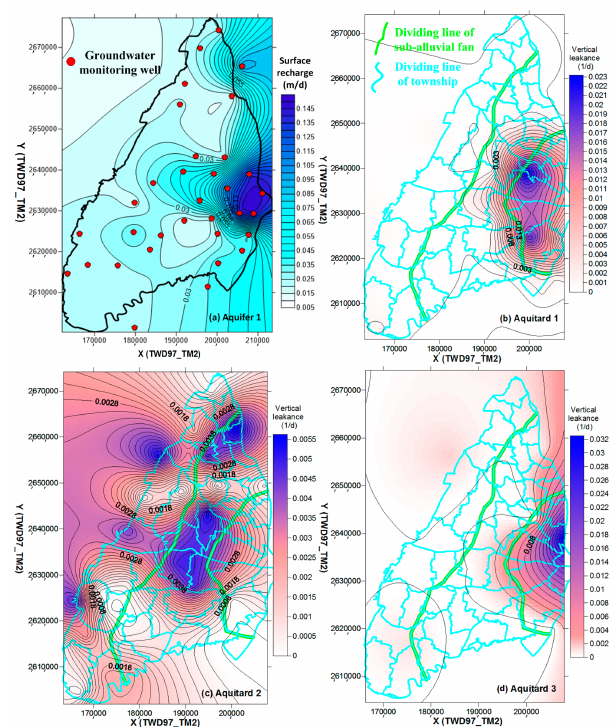
Figure 11. The identified spatial pattern of surface recharge R surf K V : ( a ) Aquifer 1; ( b ) Aquitard 1; ( c ) Aquitard 2; and ( d ) Aquitard 3. s f , f